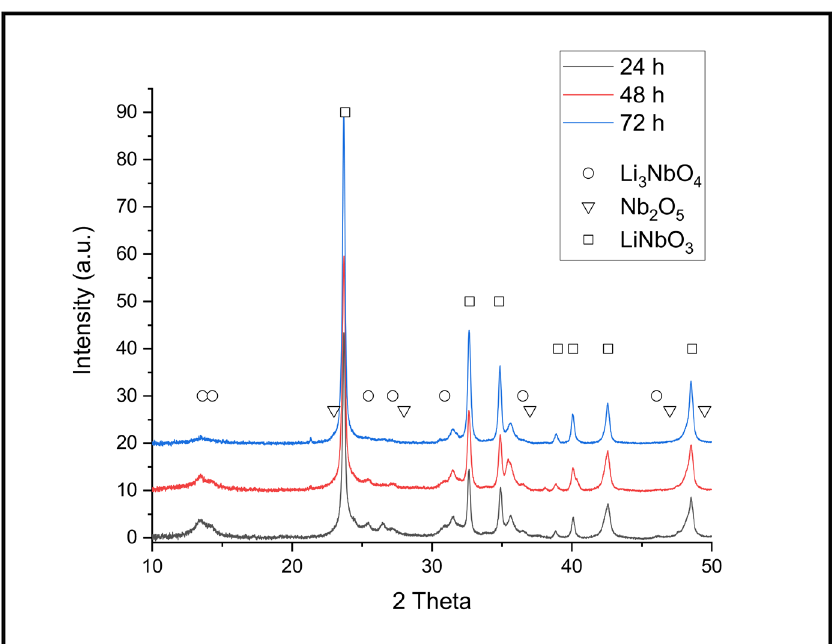
Figure 4. Effect of the reaction time on the chemical synthesis of LN as shown by the XRD diffrac- tograms (the fixed synthesis parameters for the different samples were diethylene glycol as solvent and r = 1). The intensity of the diffraction peaks corresponding to the Li 3 NbO 4 phase decreases with the increasing reaction time. A similar trend could be observed in the case of the other time triplets.